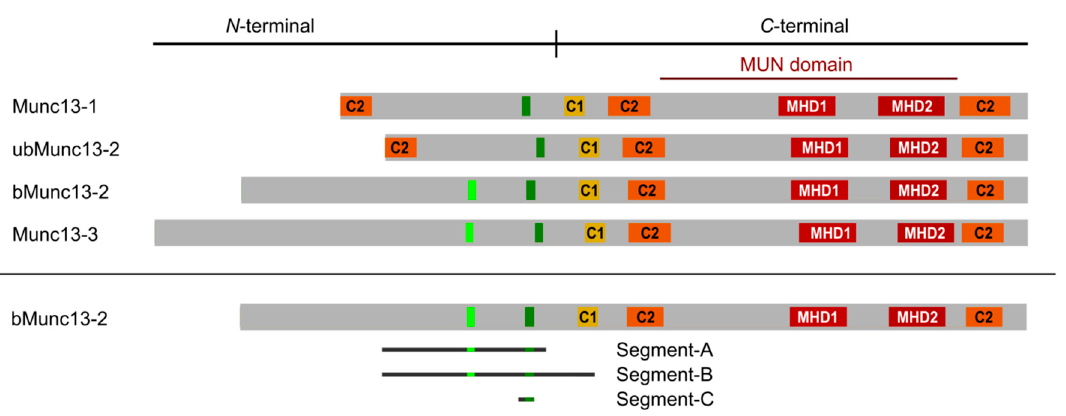
Figure 1. Domain structure of Munc13 proteins. All Munc13 isoforms share a conserved C -terminal priming unit and a central regulatory unit. Munc13-1 and ubMunc13-2 have a homologous N -terminal region containing an additional C2 domain. CaM-binding sites (dark green bars) are located in the regulatory unit. In bMunc13-2 and Munc13-3, another candidate CaM binding site (light green bars) was initially identified by computational methods, but found to be deficient of CaM-binding in the protein context [28]. C1 = diacylglycerol binding domain (yellow), C2 = Ca 2 + -binding / protein interaction domain (orange), MHD = Munc homology domain (red). The bMunc13-2 segments investigated in this study are displayed. Segment-A (aa 367 ‒ 780), segment-B (aa 367 ‒ 903), and segment-C (aa 703/704 ‒ 742).